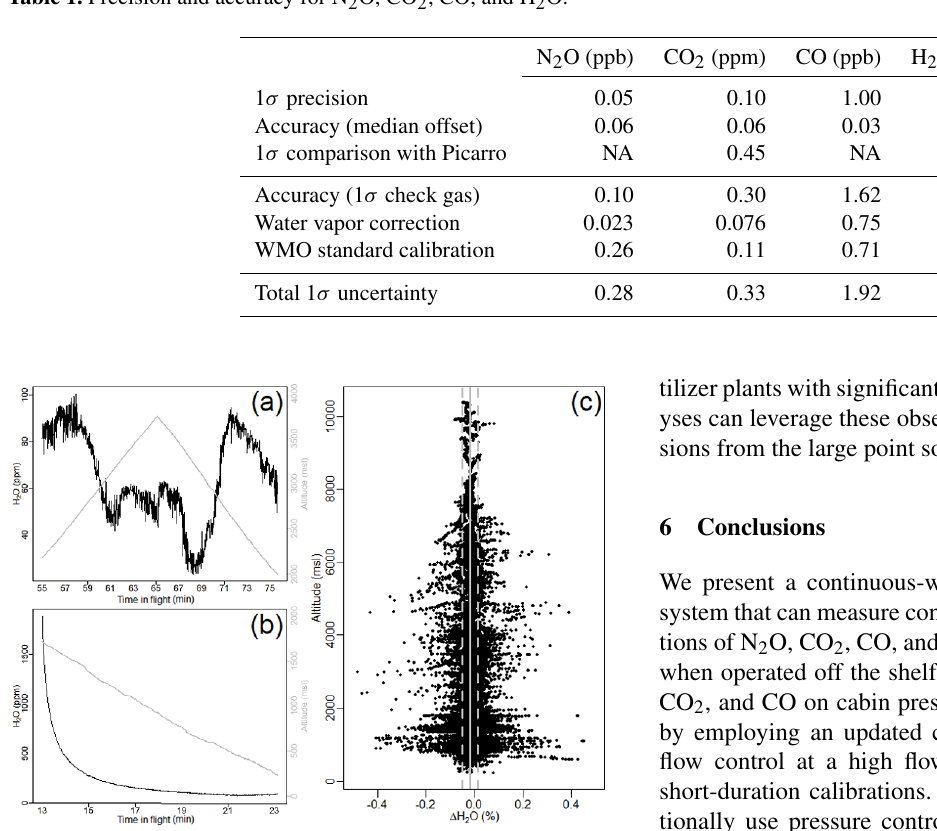
Figure 11. Panels (a) and (b) show H 2 O during null tests from Fig. 7. In (b) H 2 O has not fully equilibrated. In (a) , H 2 O previously equilibrated and there does appear to be a dependence on altitude on the order of 60ppm. As seen in (c) , the difference in H 2 O between the Picarro and FCHAOS over the entire campaign does not exhibit an altitude dependence, so while there may be some altitude sensi- tivity, the effect is relatively small compared to typical atmospheric concentrations of H 2 O and our overall water vapor